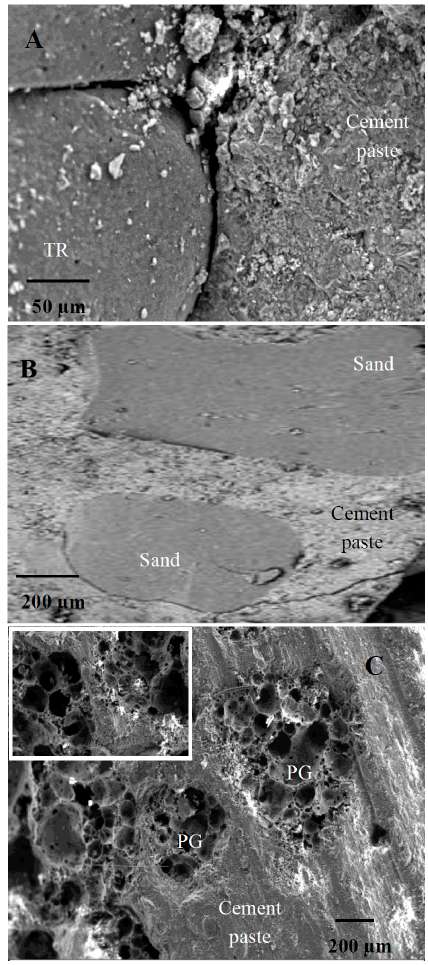
Figure 5. SEM images of: ( A ) cement/TR interface, ( B ) cement/sand interface, ( C ) cement/PG interface.